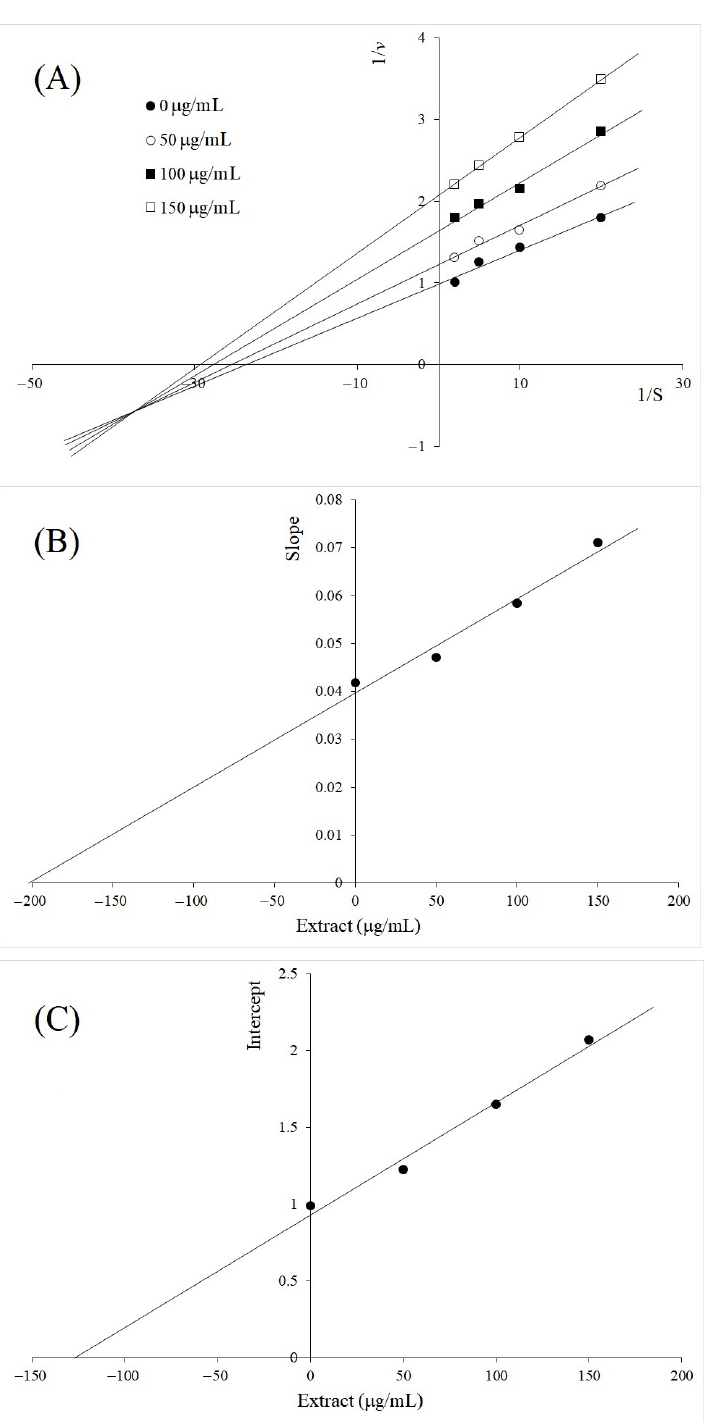
Figure 3. Inhibition kinetics of Alpinia galanga rhizome BL on TYR diphenolase activity at different concentrations (50, 100 and 150 µg/mL). ( A ) Lineweaver–Burk plot; ( B ) secondary plot between inhibitor concentration and the slope (linear equation; y = 0.0001980x + 0.03970, R 2 = 0.9704); ( C ) secondary plot between inhibitor concentration and intercept (linear equation; y = 0.007311x + 0.9331, R 2 = 0.9856).